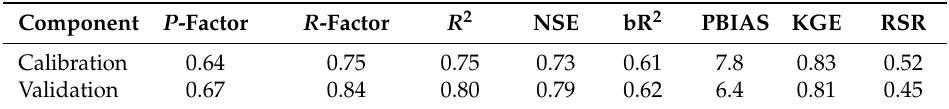
Table 6. Monthly measured and simulated sediment yield calibration (1991–2000)—validation (2002–2007) model performance